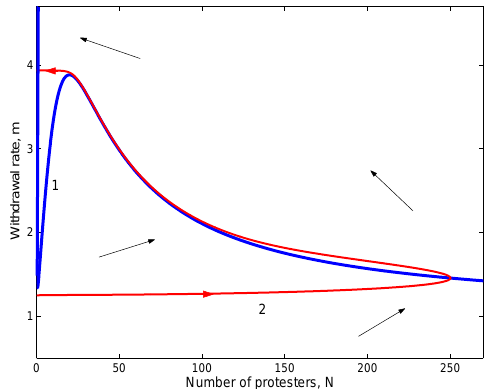
Figure 3. Phase plane of the system (7). The blue Curve 1 shows the N -isocline; note its part that lies close to the vertical axis. The red Curve 2 shows the solution of the system (obtained for parameters (cid:101) 0 = 0.1, (cid:101) = 1, a = 115, h = 20, and β = 0.00025) where red arrows indicate the direction of the system’s evolution along the trajectory. The black arrows show the generic direction of the phase flow in different parts of the plane.